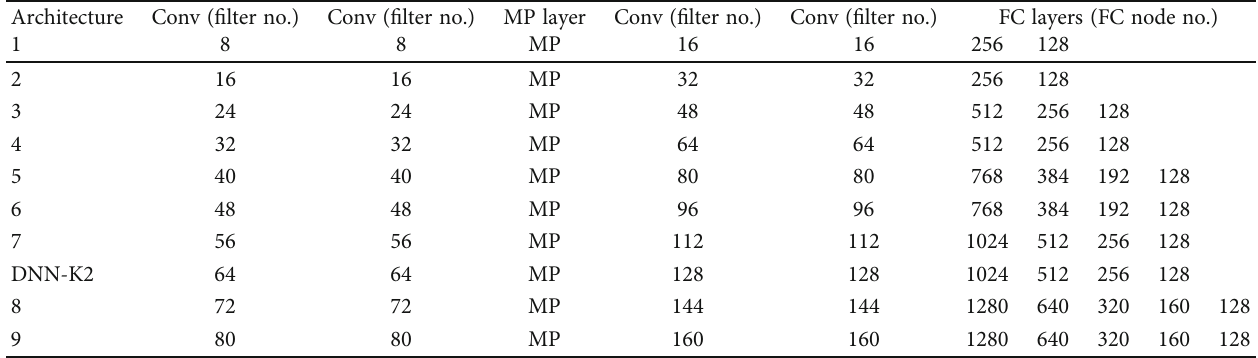
Table 6: Di ff erent CNN architectures adopted in studying the CNN fi lter numbers; LSTM branches of all listed architectures remain the same as in Figure